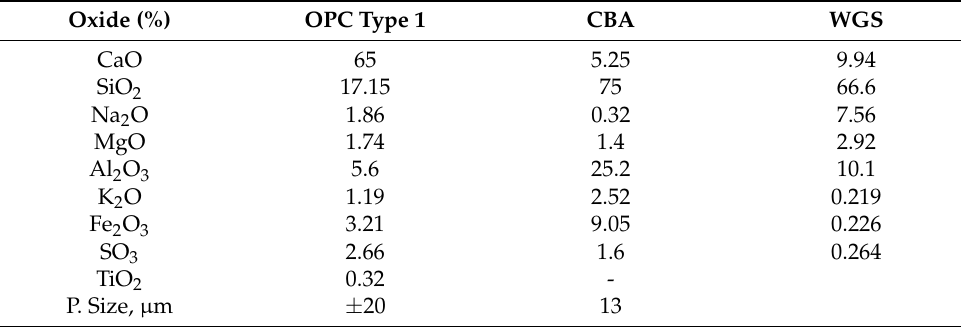
Table 1. Chemical properties of cement, CBA and